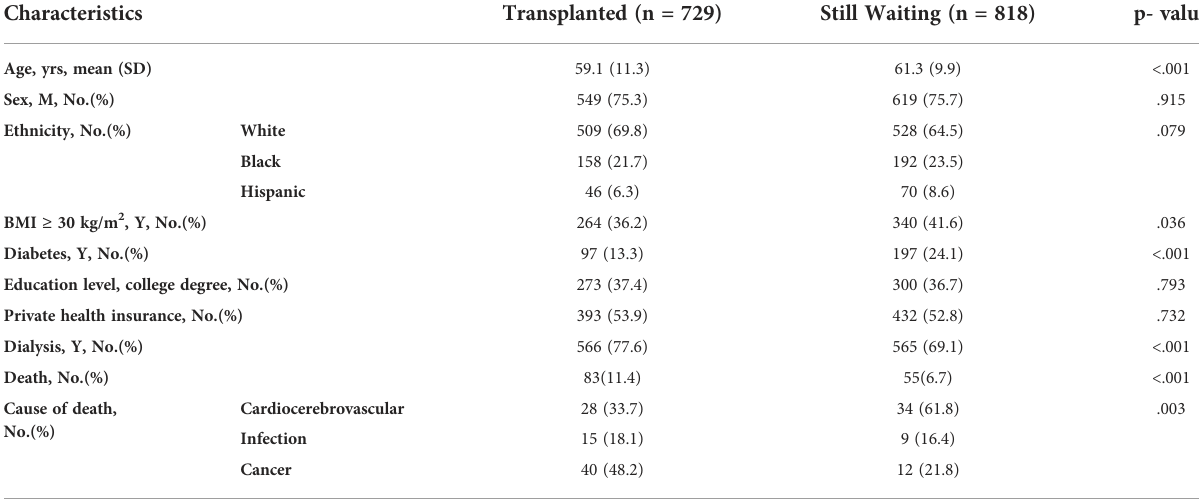
TABLE 5 Renal cell carcinoma (RCC) patients ’ characteristics and cause of death at most recent follow-up.